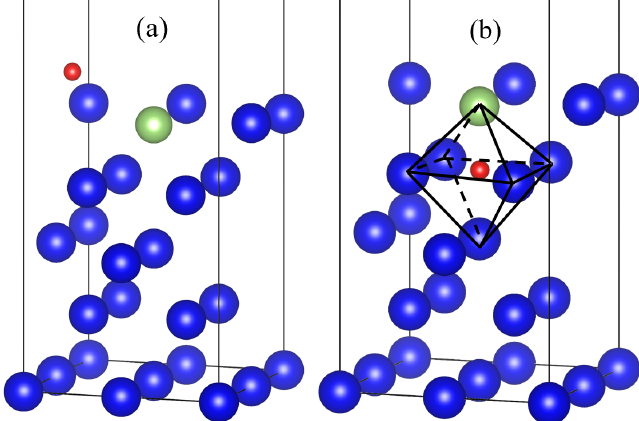
Figure 8. Transition state calculation of initial and final states: ( a ) initial state; ( b ) final state.